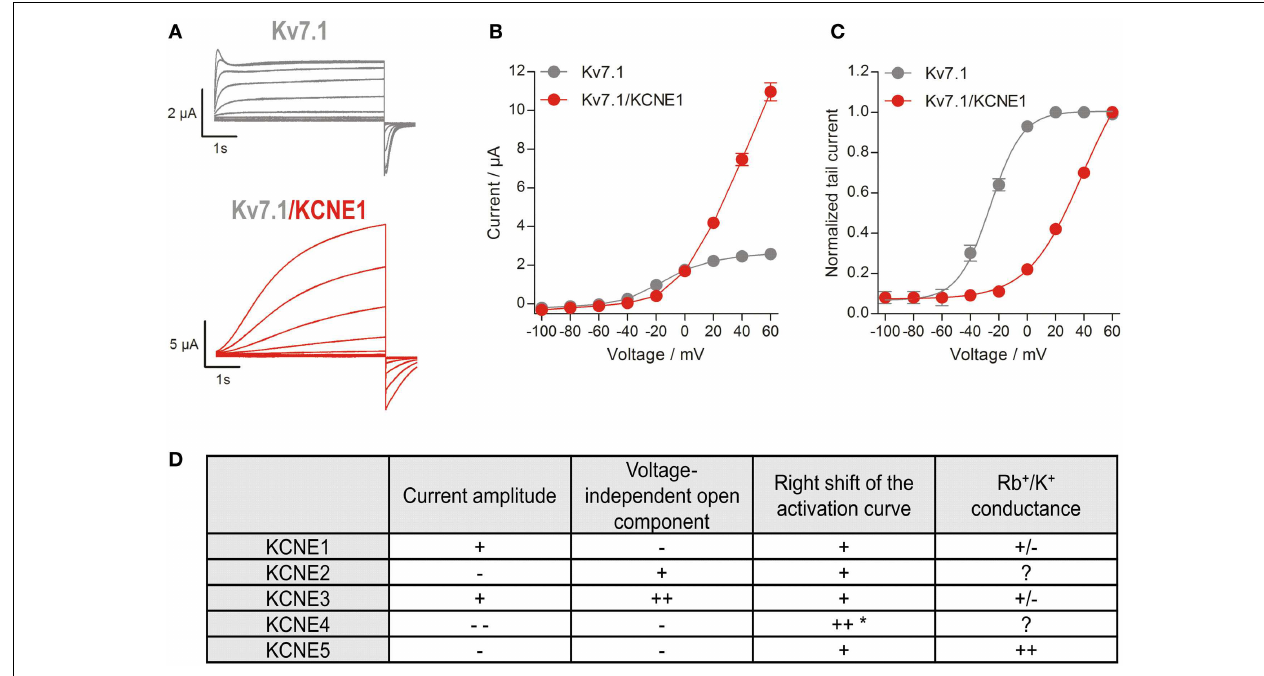
were fitted to a Boltzmann function. Note: Kv7.1/KCNE1 channels are not fully activated at + 60mV. (D) Effects of different KCNE subunits on Kv7.1 currents. “ + ” and “ ++ ” indicate increased and strongly increased effects, while “ − ” and “ −− ” indicate decreased and strongly decreased effects, respectively. *Effect shown in the calmodulin binding-deficient KCNE4 L69–L72 mutant (Ciampa et al., 2011).The Rb + /K + conductance tightly correlates with the partial inactivation, and KCNE5 slightly increases it, whereas KCNE1/3 decreases it compared to Kv7.1 (Seebohm et al.,